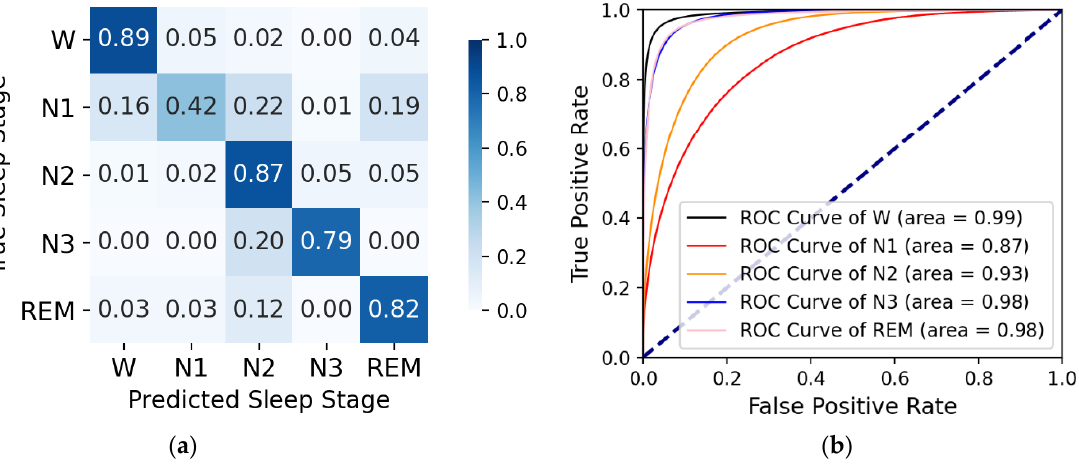
Figure 5. The CAttSleepNet model ’ s confusion matrix and ROC curve are obtained from the Pz-Oz channel of the sleep-edfx-2013 dataset. ( a ) Confusion matrix; ( b ) ROC curve.